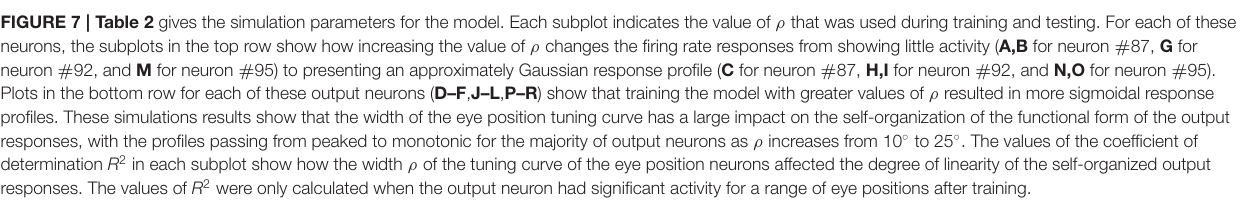
FIGURE 7 | Table 2 gives the simulation parameters for the model. Each subplot indicates the value of ρ that was used during training and testing. For each of these neurons, the subplots in the top row show how increasing the value of ρ changes the firing rate responses from showing little activity ( A,B for neuron # 87, G for neuron # 92, and M for neuron # 95) to presenting an approximately Gaussian response profile ( C for neuron # 87, H,I for neuron # 92, and N,O for neuron # 95). Plots in the bottom row for each of these output neurons ( D–F , J–L , P–R ) show that training the model with greater values of ρ resulted in more sigmoidal response profiles. These simulations results show that the width of the eye position tuning curve has a large impact on the self-organization of the functional form of the output responses, with the profiles passing from peaked to monotonic for the majority of output neurons as ρ increases from 10 ◦ to 25 ◦ . The values of the coefficient of determination R 2 in each subplot show how the width ρ of the tuning curve of the eye position neurons affected the degree of linearity of the self-organized output responses. The values of R 2 were only calculated when the output neuron had significant activity for a range of eye positions after